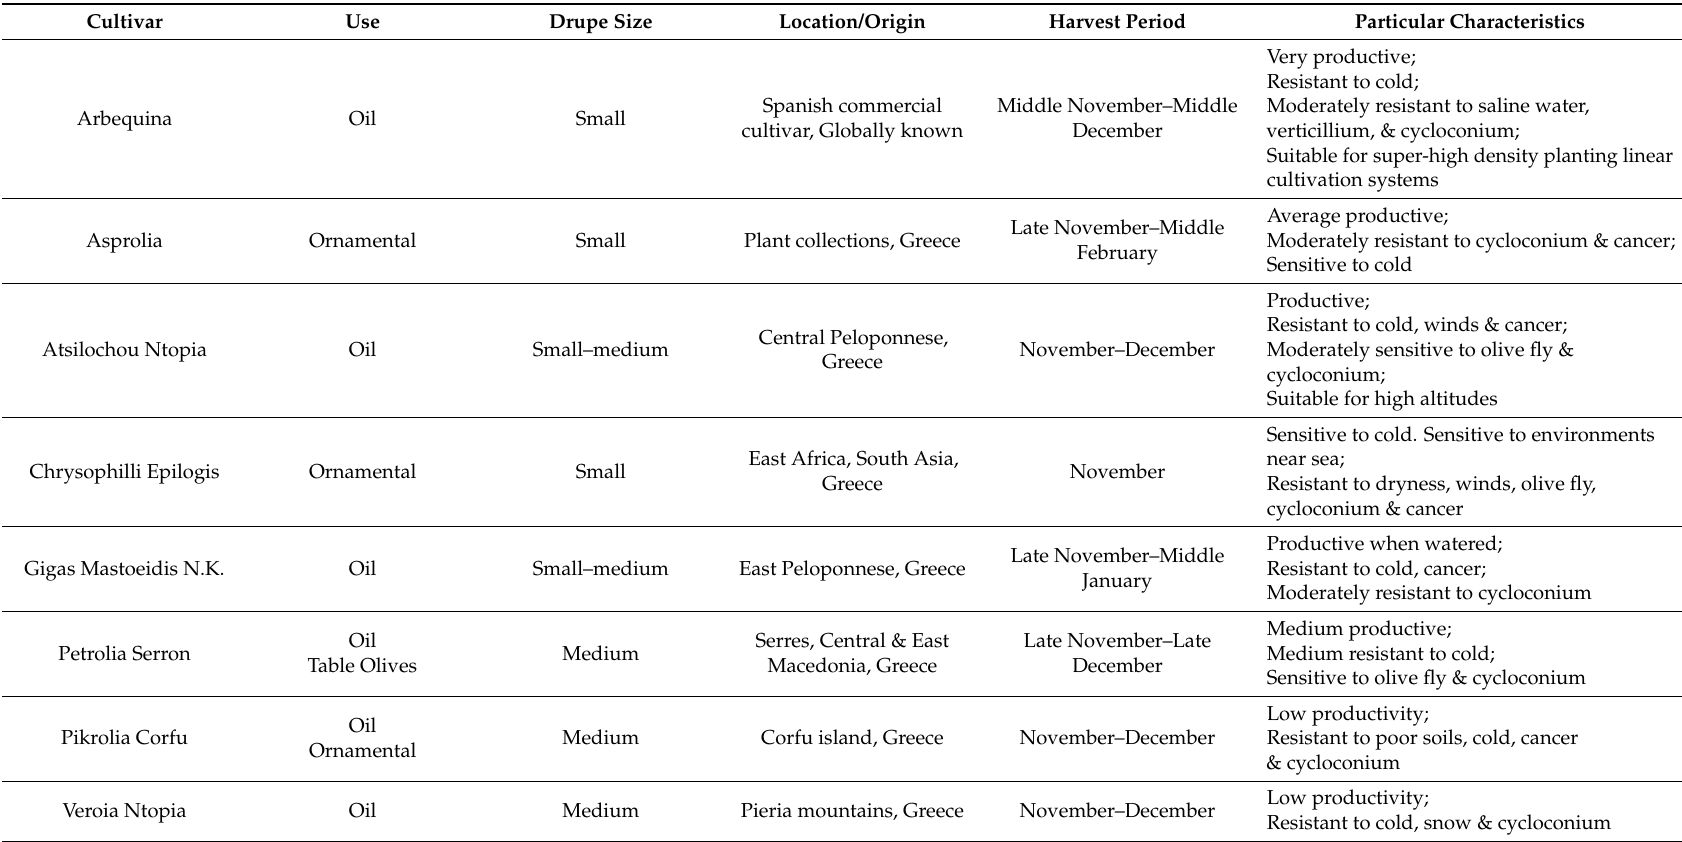
Table 1. Characteristics of the olive cultivars employed in the present study